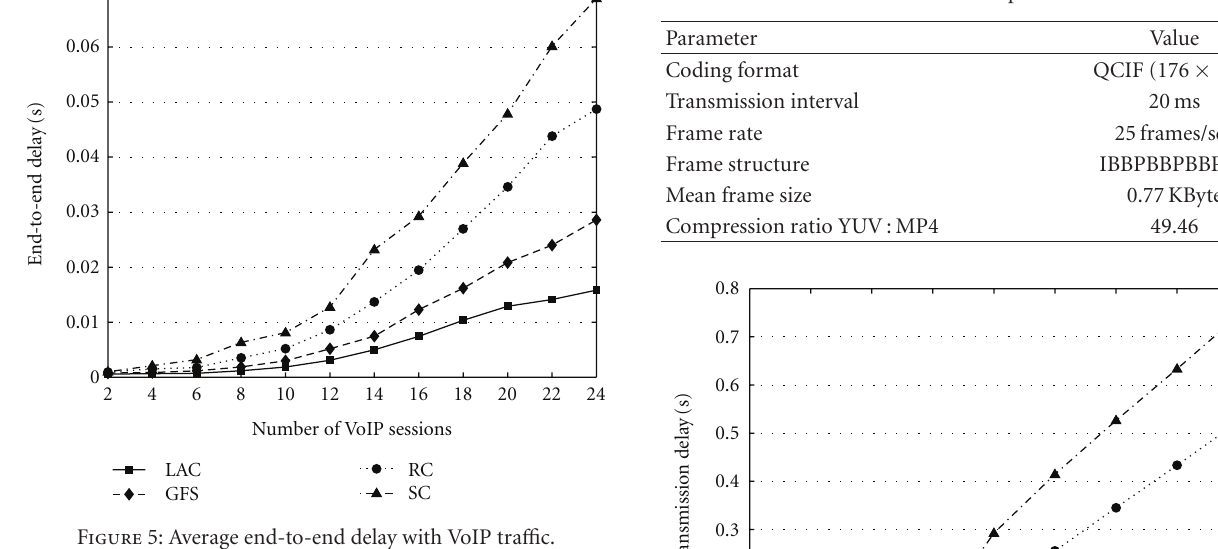
Table 1: Video tra ffi c parameters.